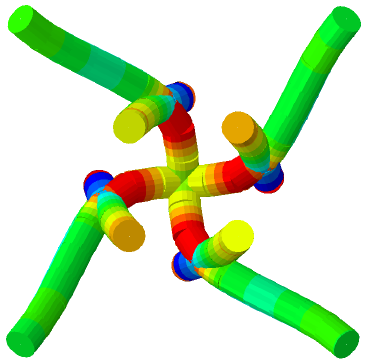
Figure 5. The deformation of a unit cell with different loads. ( a ) 1 t; ( b ) 0.8 t; ( c ) 0.6 t.